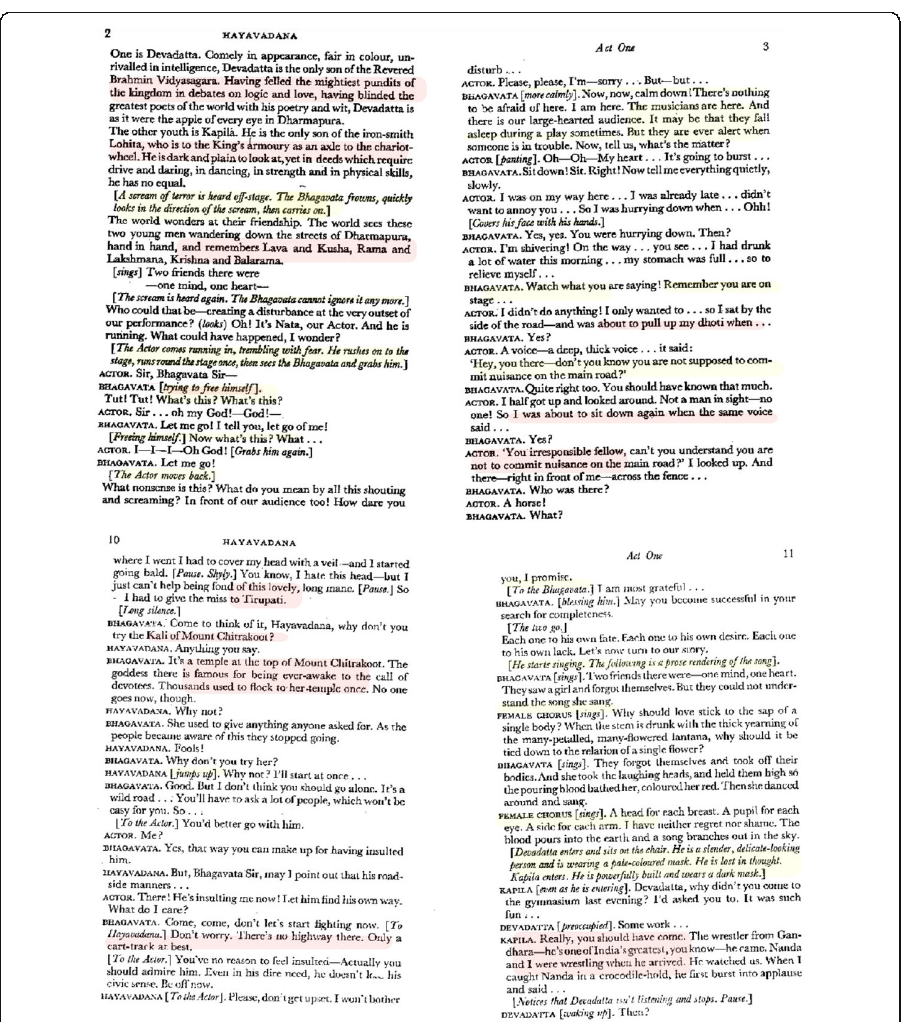
Fig. 2 Cultural references and performative elements in page 8 and page 12 of content